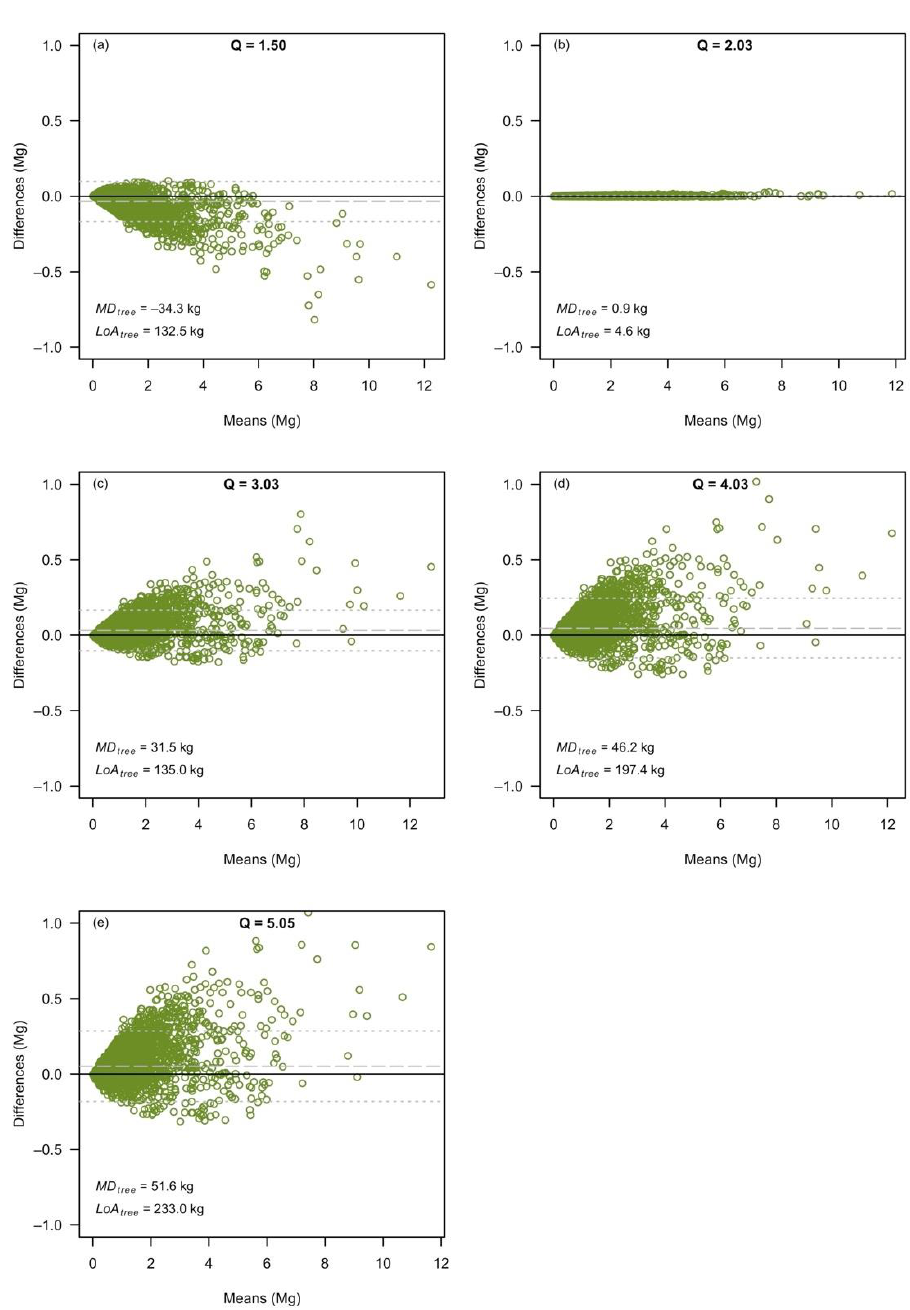
Figure 1. The Bland – Altman plots, comparing the individual tree predictions, for trees in the inven- tory dataset, as predicted by the separate variable models and the combined variable models, based on Dataset Q1 ( a ), Dataset Q2 ( b ), Dataset Q3 ( c ), Dataset Q4 ( d ) and Dataset Q5 ( e ). Note: the dashed grey line represents the mean difference ( MD tree ), and dotted grey lines show the limits of agreement ( LoA tree ).